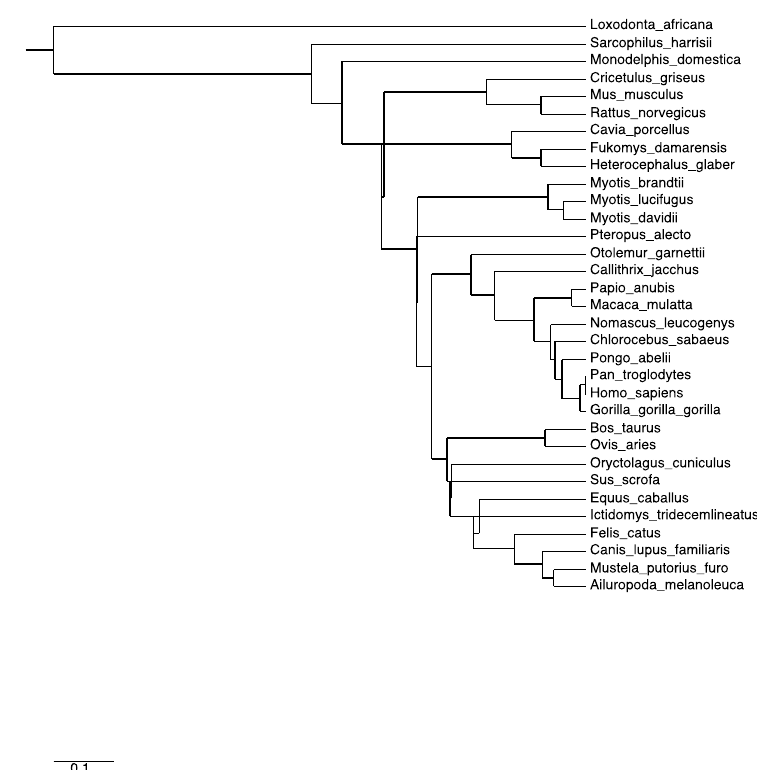
Figure 5. Phylogenetic tree computed from multiple alignment distances of mammalian OAT sequences.